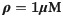
Time evolution of the uncertainty on the estimations, ρ=1μM.A priori
kon0=0.031min-1μM-1, kdep0=0.09min-1, kdis0=0.07min-1, θ0 = 0.2, observation covariance W = 10, predicted standard deviation of initial a priori estimations as in Table 2. A: One curve every ten iterations of the Extended Kalman method, number of the iteration in colorscale. B: Trajectories of the final estimators (red solid lines), the final estimations (red dashed lines) and 95% prediction uncertainty intervals (red areas). From the left to the right estimators of kon, kdep, kdis and θ.